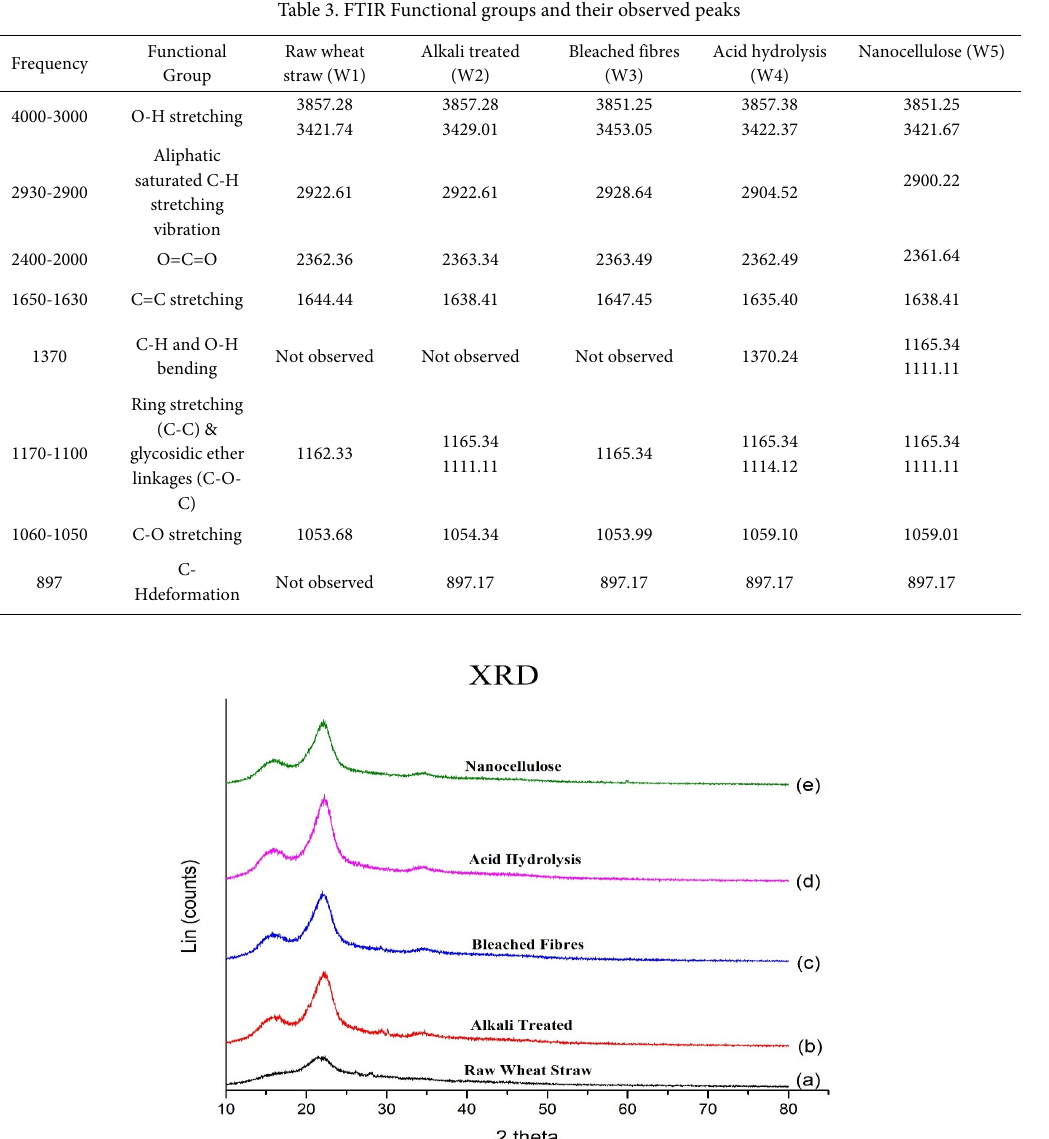
Fig. 4. XRD Graph of (a) Raw Wheat straw, (b) Alkali treated, (c) Bleached fibres, (d) Acid hydrolysis and (e) Nanocellulose